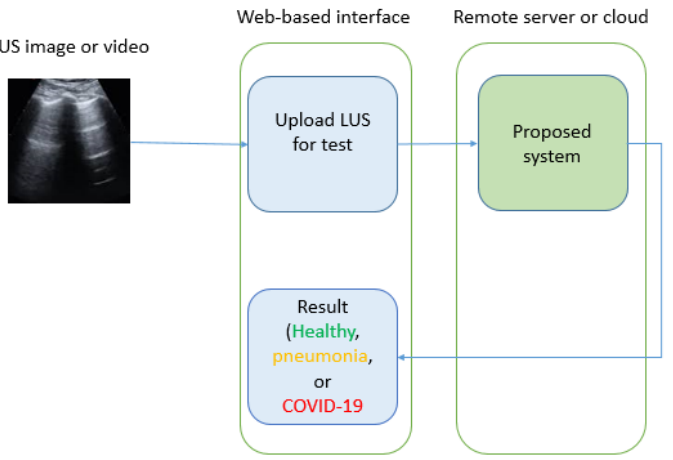
Figure 8. T he deployment of the proposed model at the point of care. Figure 8. The deployment of the proposed model at the point of